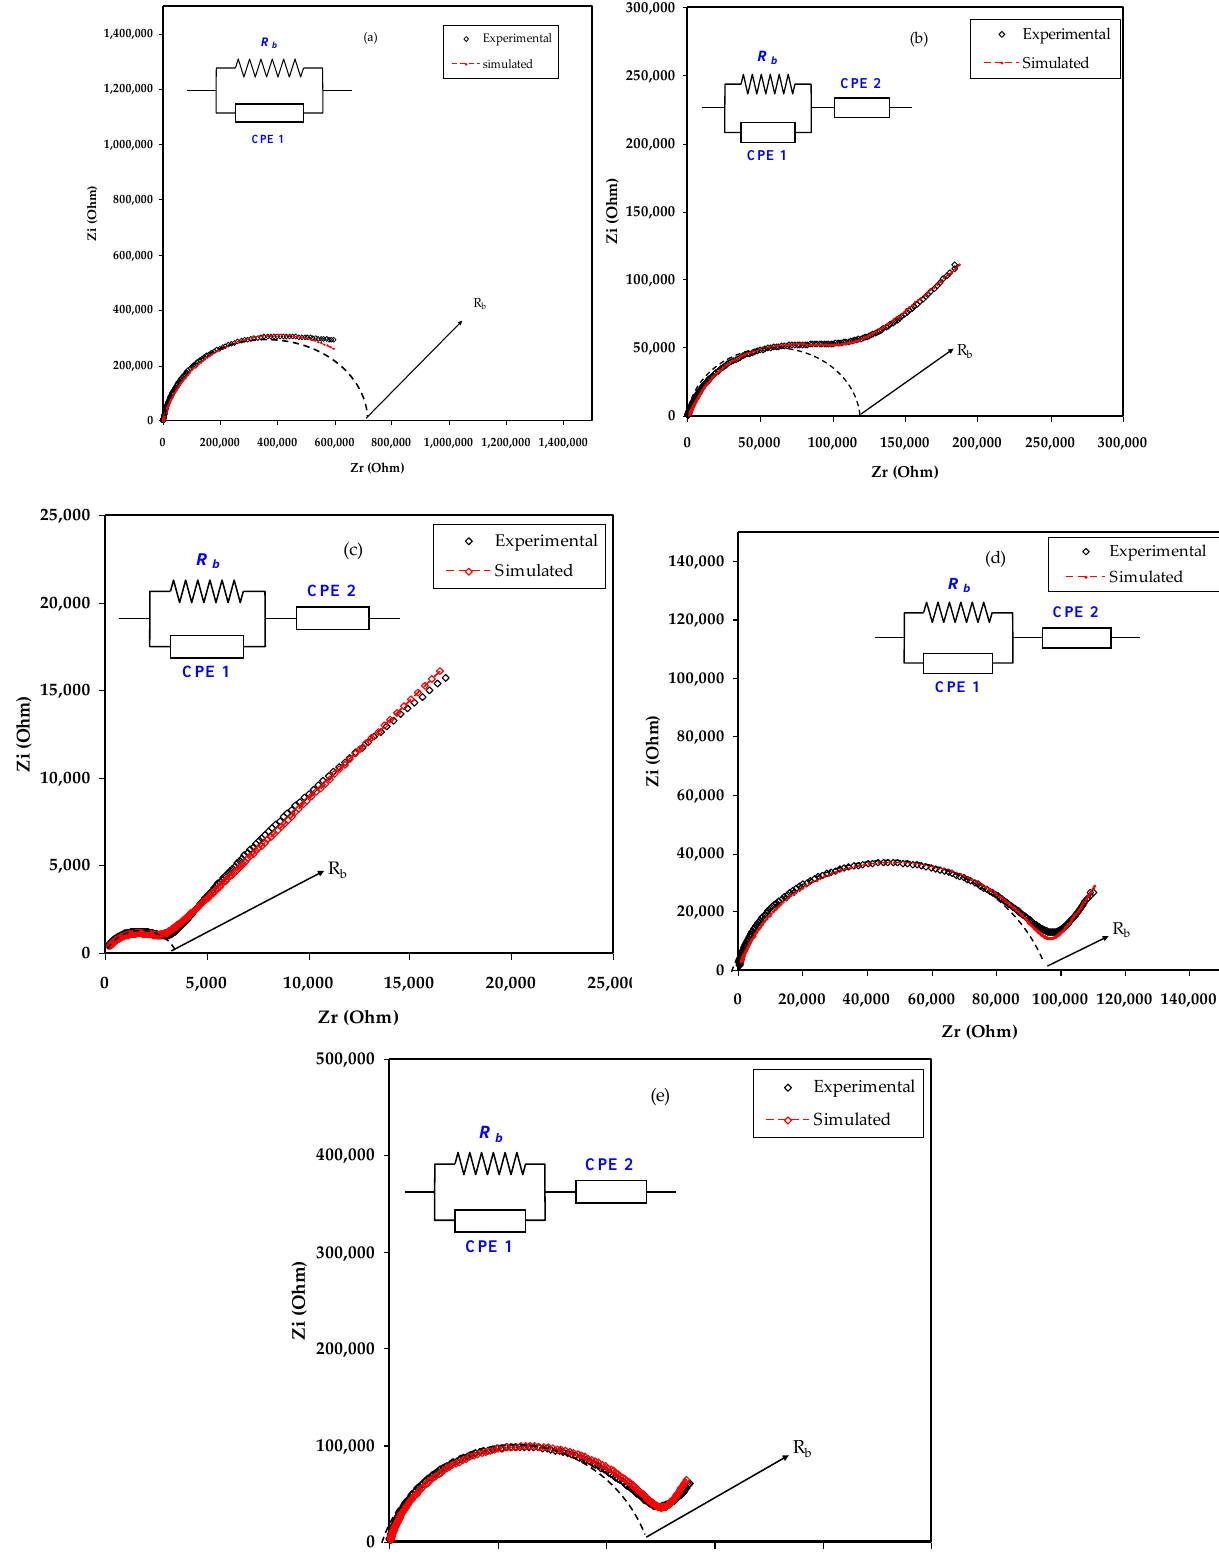
Figure 4. Experimental and fitting (EEC) impedance (Nyquist) plots for ( a ) MCNAB 1, ( b ) MCNAB 2, ( c ) MCNAB 3, ( d ) MCNAB 4, and ( e ) MCNAB 5 samples. Table 2. The parameters of the circuit elements of the films at room temperature.